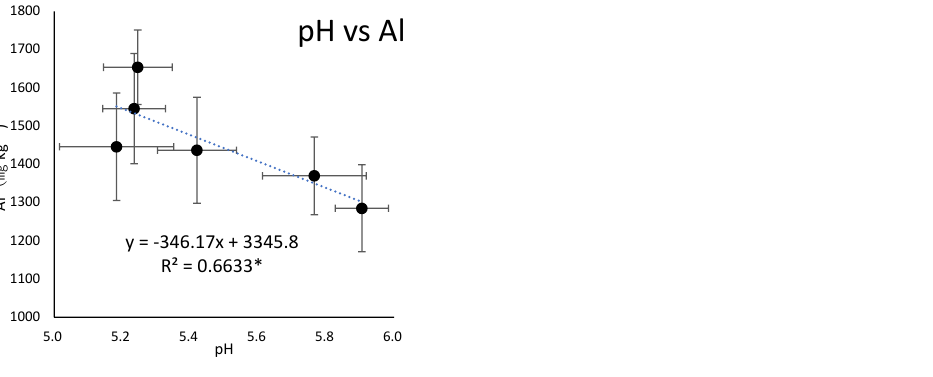
Figure 7. Relationships between years of ginseng cultivation and trace elements and soluble Al in the soil. Mean values ± standard errors ( n = 3). * Represents significance at the 0.05 probability level.